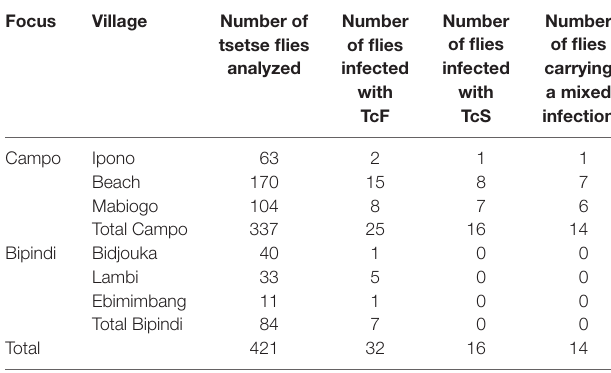
Table 3 | Number of Trypanosoma congolense s.l. simple and mixed infections by village. Focus Village